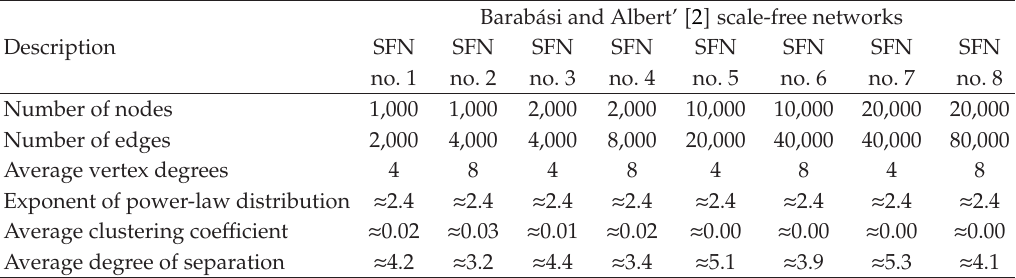
Table 5: Parameters for eight scale-free networks built using di ff erent numbers of nodes and average vertex